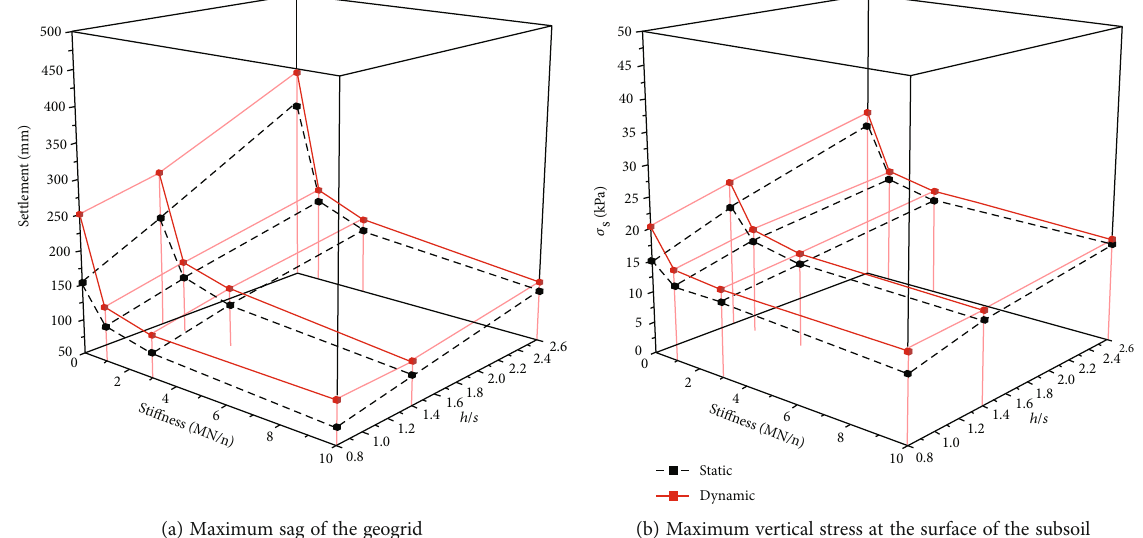
Figure 5: E ff ect of geogrid sti ff ness on the maximum geogrid sag and stress distributed at the surface of soft soil over point